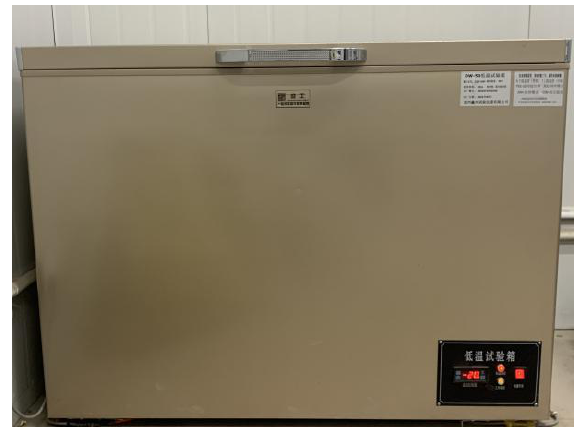
Figure 1. Low-temperature test chamber.